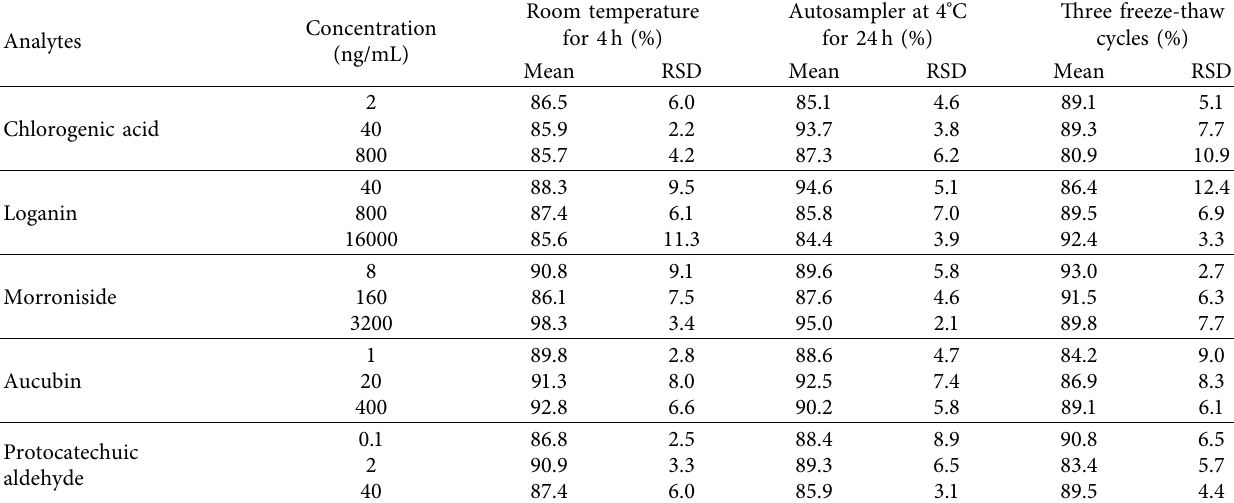
Table 6: Stability of 5 analytes in rat plasma under various conditions ( n �